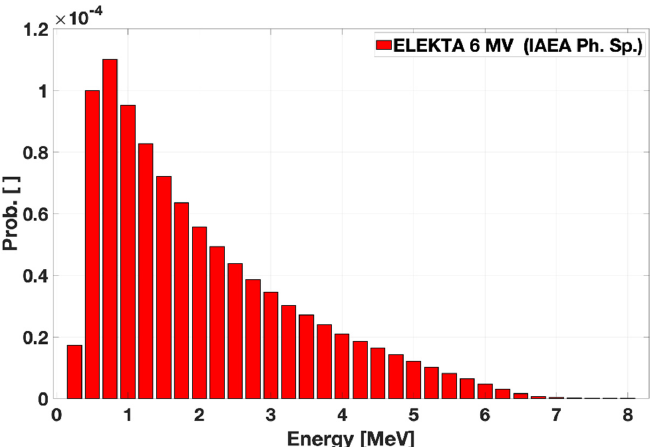
Figure 10. ELEKTA 6 MV photon spectrum as extracted from the IAEA phase space.